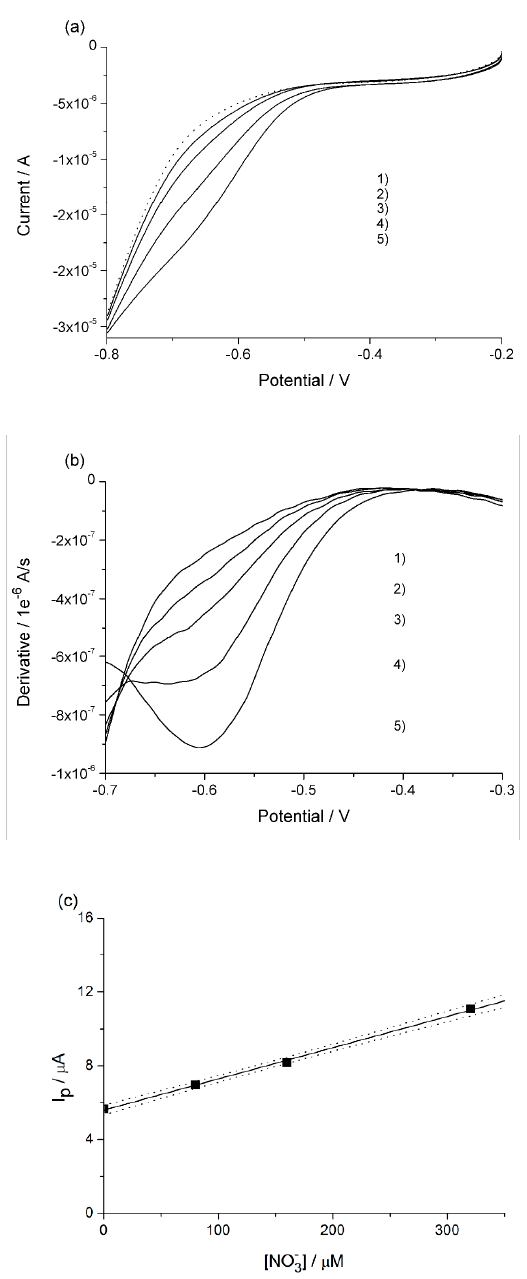
Figure 4. ( a ) Linear sweep voltammograms recorded in 10-times diluted rucola extract acidified, at scan rate of 10 mV s − 1 ; ( b ) first derivative of LSV reported in ( a ); ( c ) calibration plot, with confidence bands at 90%, obtained by standard additions of nitrate of the following concentrations in µ M: 1) 0, 2) 80, 3) 160, 4) 320, 5) 640.